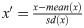
Sensitivity index of standardized yield for selected component traits involved in crop development (A), resource acquisition (B), biomass production (C) and biomass allocation (D) relative to seasonal water- or nitrogen-stress indices.Yield impact was assessed for the thermal time required to reach floral initiation (tt_end_of_juvenile), the water extractability by roots (ll_modifier), the radiation use efficiency (y_rue), and biomass allocation to grains (potential_grain_filling_rate). As sensitivity indices are computed independently for each condition (combinations of sites × year × management), a standardized sensitivity index was used to allow comparison of indices across environments. In this case, simulated yield was standardized (x′=x-mean(x)sd(x)) within each of the 9000 environment conditions before computing elementary effects and sensitivity indices (which are always positive in Morris method). The water-stress index [7] indicates the degree to which the soil water extractable by roots (water supply) is able to match the potential crop transpiration (water demand). The nitrogen-stress index is a factor computed by APSIM that determines limiting N level affecting leaf photosynthesis [29]. Both indexes ranged from 0 (no-stress) to 1 (extreme stress). Data are presented for representative drought-pattern environment types (colors), namely “low” (ET1) with stress-free or short-term water-deficits; “mild-late” (ET2) with mild water shortage mainly occurring during grain filling; “mild-early” (ET3) with severe water stress starting during the vegetative stage and relieved during mid-grain filling; and “severe” (ET4) with water deficit from early stages throughout the grain-filling periods [7]. Lines represent linear regressions fitted by environment types.